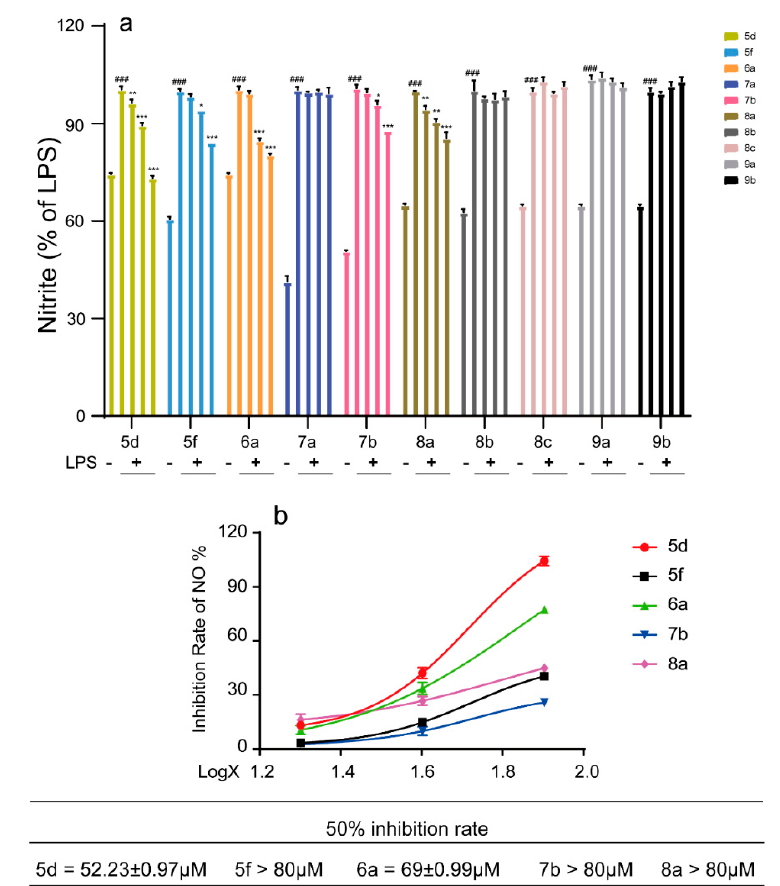
Figure 6. Inhibitory effect of compounds 5d , 5f , 6a , 7a , 7b , 8a – 8c , 9a , 9b (0–80 µ M) on over expression of NO in RAW264.7 cells. RAW264.7 cells were treated with the selected compounds for 1 h, and then incubated with LPS for 18 h. The supernatant was collected, and the content of nitrite was detected by Griess assay. All the experiments were independently performed three times. * p < 0.05, ** p < 0.01, and *** p < 0.001 compared with the LPS group; ### p < 0.001, compared with control group.